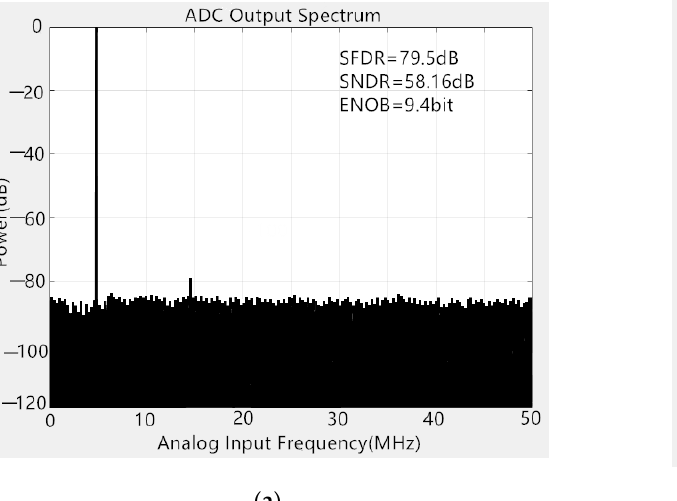
Figure 21. Measured Spectrum at Fin = 4.89 MHz when ( a ) calibration was off and ( b ) calibration was on .